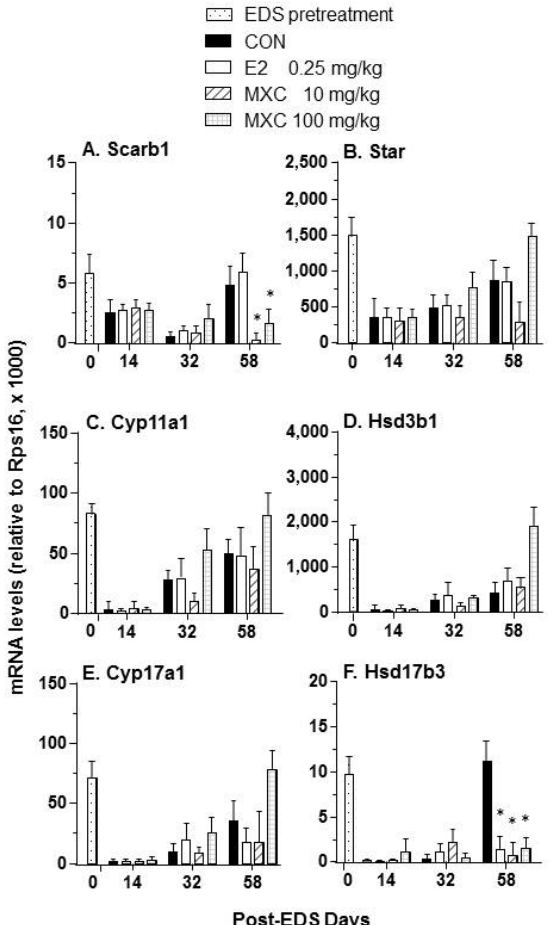
( A ) Scarb1; ( B ) Star; ( C ) Cyp11a1; ( D ) Hsd3b1; ( E ) Cyp17a1; ( F ) Hsd17b3. Mean ± SEM, n = 5. * indicates significant difference when compared to the control (CON) at each time point at p <